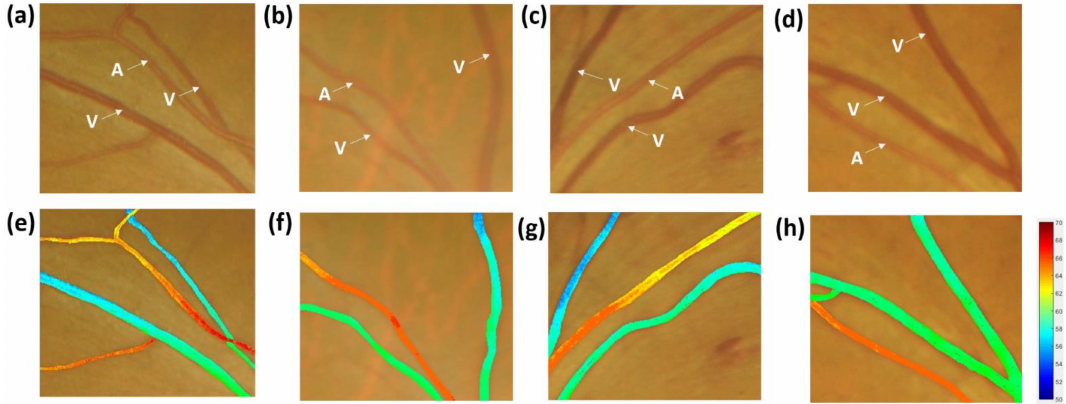
Figure 7. The local retinal images are ( a ) Normal, ( b ) BDR, ( c ) PPDR, and ( d ) PDR; the oxygen saturation profiles are ( e ) Normal, ( f ) BDR, ( g ) PPDR, and ( h ) PDR.